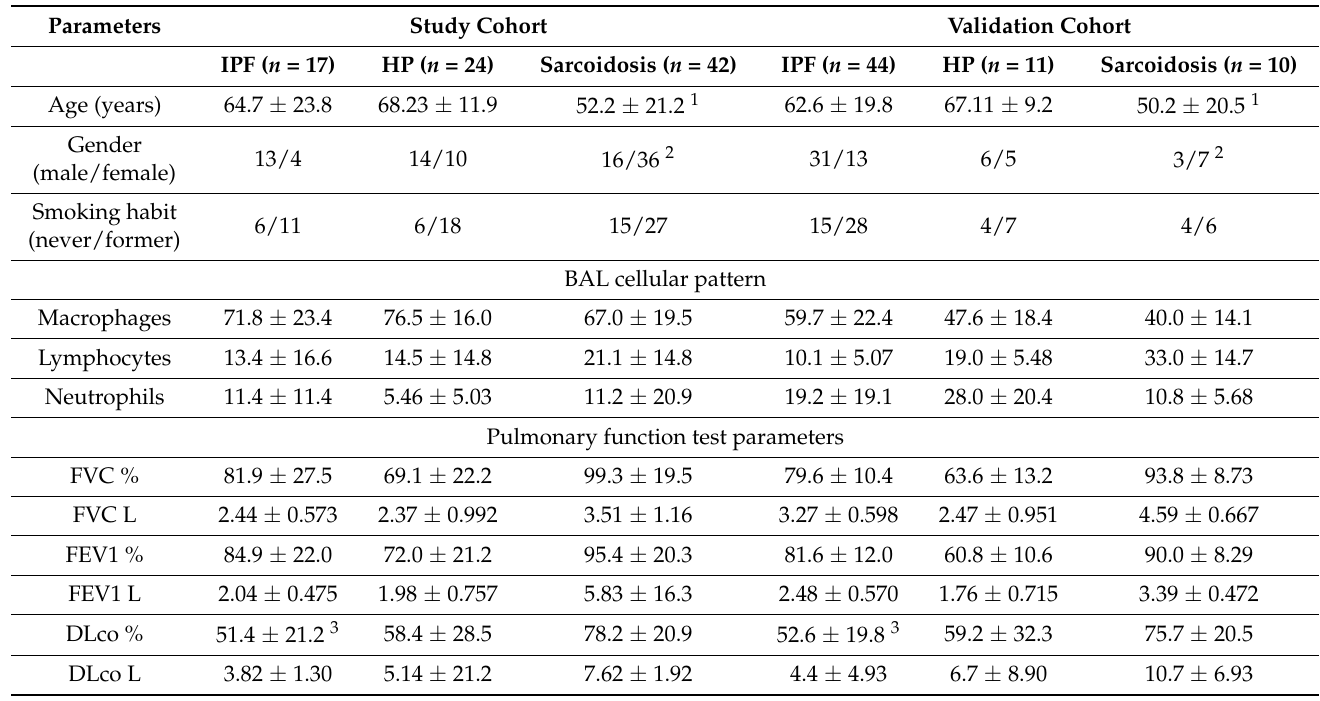
Table 1. Demographic and clinical data including age, gender and smoking habit as well as BAL cellular patterns and PFT parameters in study and validation cohorts. All parameters were expressed as mean ± standard deviation. 1 Prevalence of younger in sarcoidosis than HP and IPF, p = 0.0215; 2 prevalence of female in sarcoidosis than IPF and HP, p = 0.121; 3 reduction of DLCO percentages in IPF than sarcoidosis and HP, p = 0.0399. Abbreviations: IPF, idiopathic pulmonary fibrosis; HP, hypersensitivity pneumonitis; BAL, bronchoalveolar lavage; FVC, forced vital capacity; FEV1, forced expired volume in 1 s; DLco, diffuse lung monoxide carbon; L,